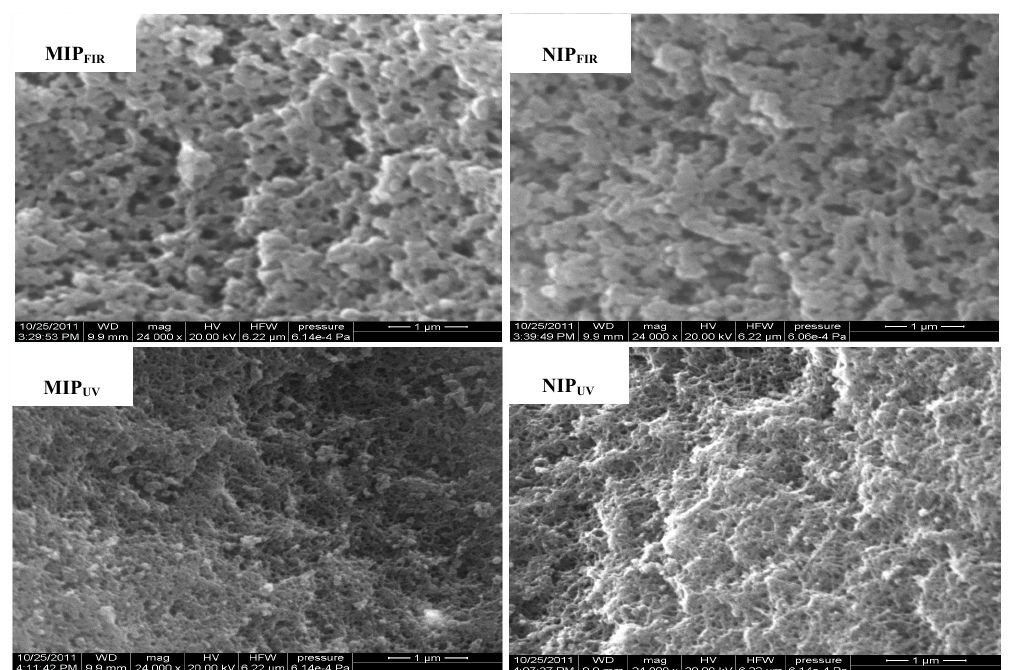
Figure 1. SEM of MIPs and NIPs prepared by FIR- and UV-polymerization